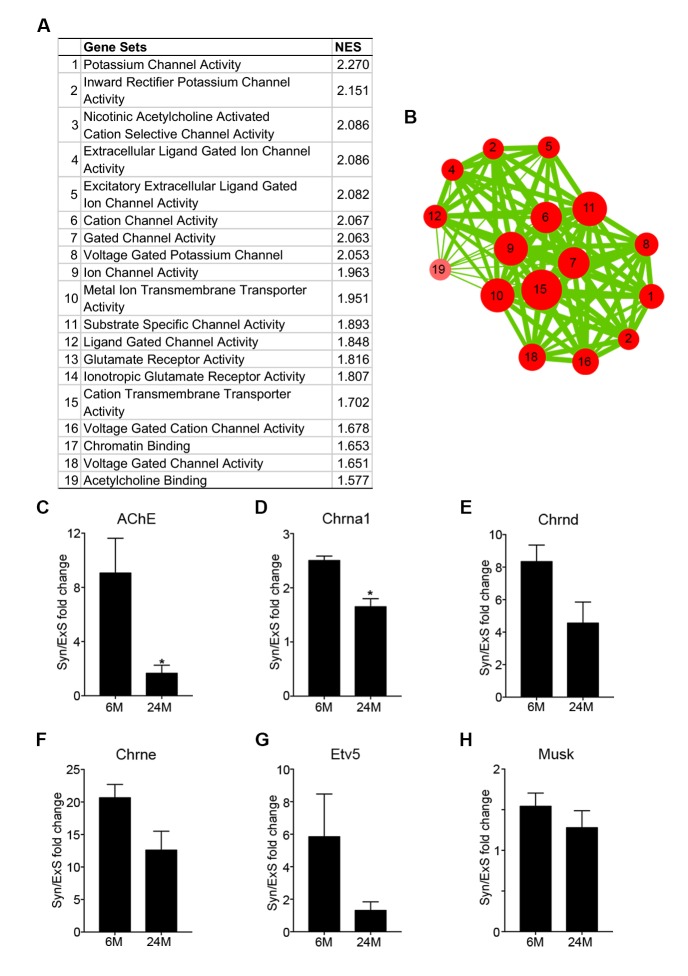
Synaptic specific gene enrichment declines with age.(A) Top 19 gene sets enriched in adult synaptic diaphragms from gene set enrichment analysis (GSEA) between adult synaptic (6M-Syn) and extra-synaptic (6M-ExS) samples using gene sets derived from the Gene Ontology Molecular Function (GOMF), arranged based on normalized enrichment score (NES). (B) Enrichment results from (A) were visualized using the Cytoscape plug-in enrichment map. Each node represents a gene set, and the thickness of lines connecting two nodes represents the number of shared genes between the two gene sets. (C–H) RT-qPCR results of select NMJ-specific genes verified the trend of decreased enrichment of these genes with age. *p<0.05 compared to adult, unpaired Student’s t-tests. n = 3 mice per group (C–H).